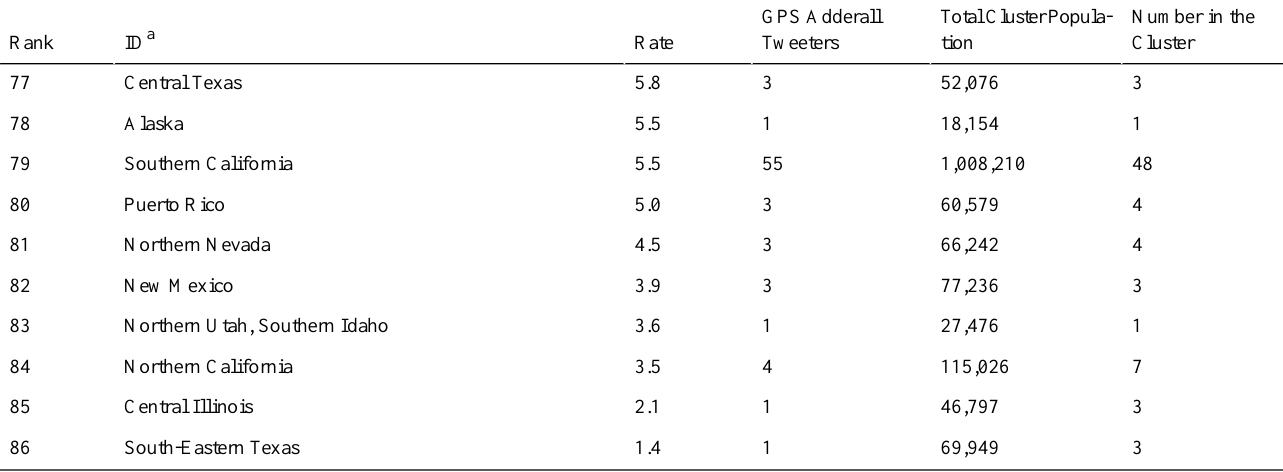
Table 4. Bottom 10 rates of Adderall tweets for 150-mile college and university clusters in the United